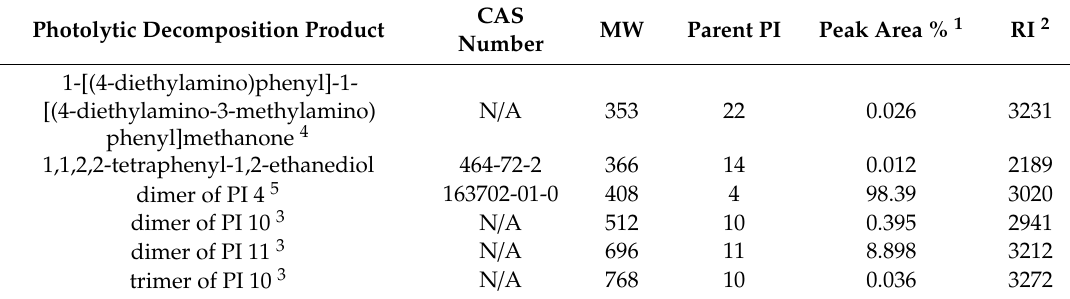
Figure 1. Numbered peaks correspond to photolytic decomposition products. Figure 2 is an exemplar ESI-MS spectrum obtained from UV-irradiated PI 10 in positive ion scanning mode.